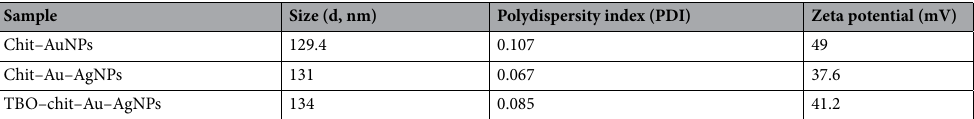
Table 1. Hydrodynamic diameter (size by number) obtained from DLS, Polydispersity index (PDI) and zeta potential values of chit–AuNPs, chit–Au–AgNPs and TBO–chit–Au–AgNPs.